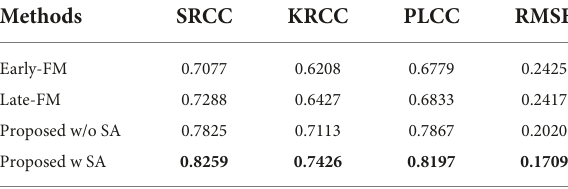
TABLE 2 Comparative results of ablation